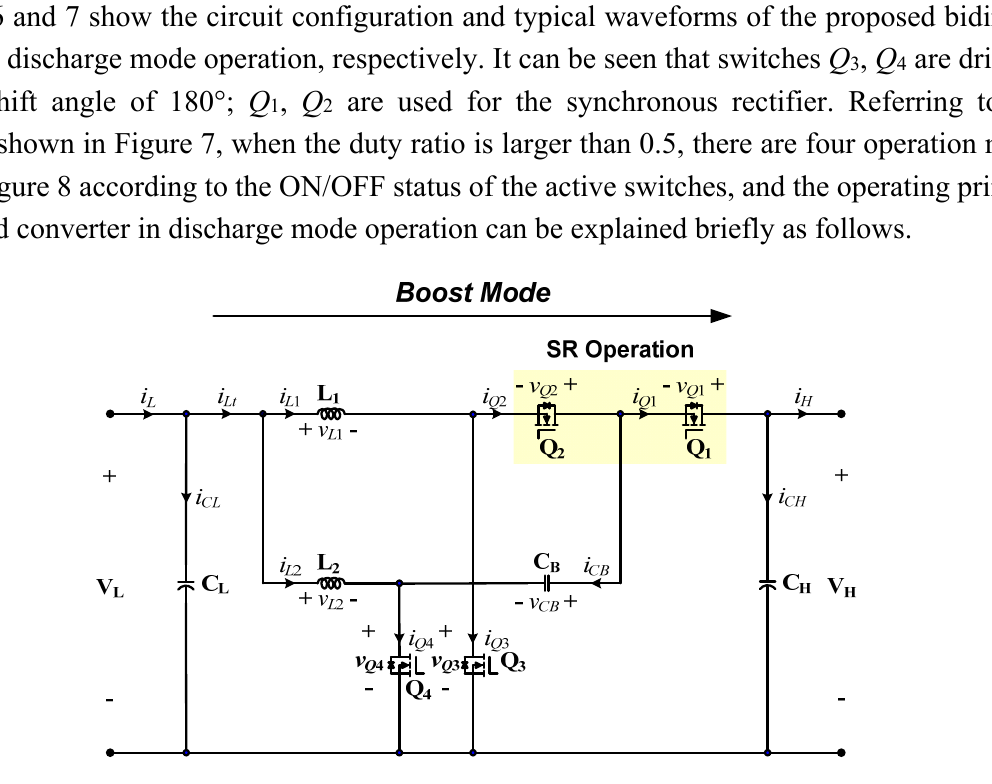
Figure 6. Circuit configuration of the proposed converter in the discharge mode